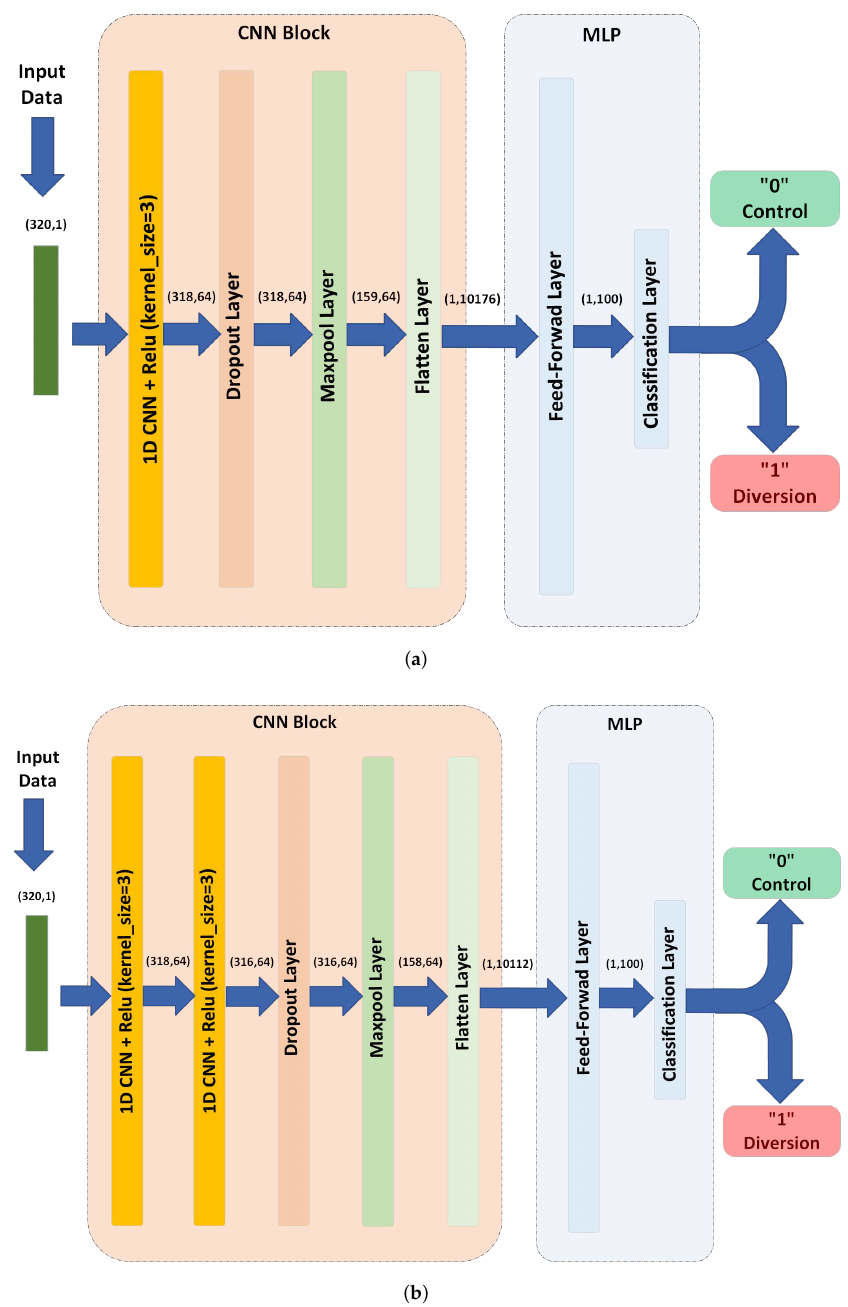
Figure 7. CNN-based models’ architectures. ( a ) CNN Model. ( b ) 2 Stacked CNN